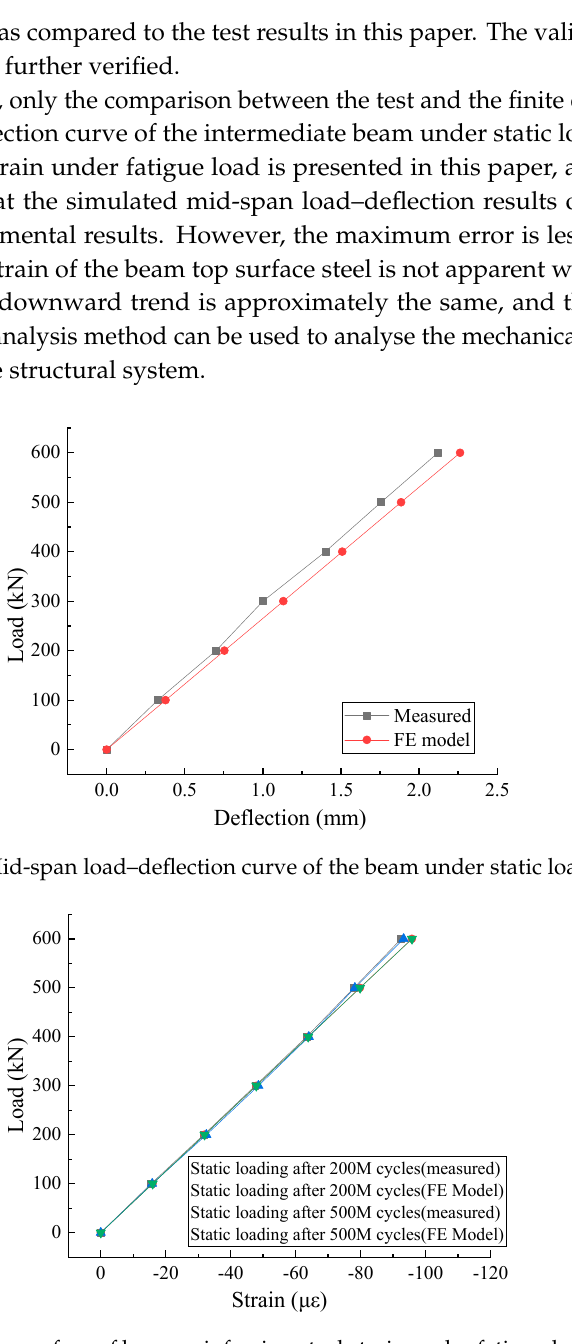
Figure 7. Top surface of beam-reinforcing steel strain under fatigue loading.